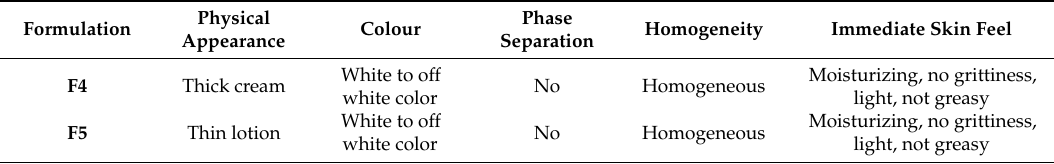
Table 4. Organoleptic characteristics of the optimized moisturizing cream (F4) and lotion (F5). Physical Phase Formulation Colour Homogeneity Immediate Skin Feel Appearance Separation White to o ff Moisturizing, no grittiness, F4 Thick cream No Homogeneous white color light, not greasy White to o ff Moisturizing, no grittiness, F5 Thin lotion No Homogeneous white color light, not